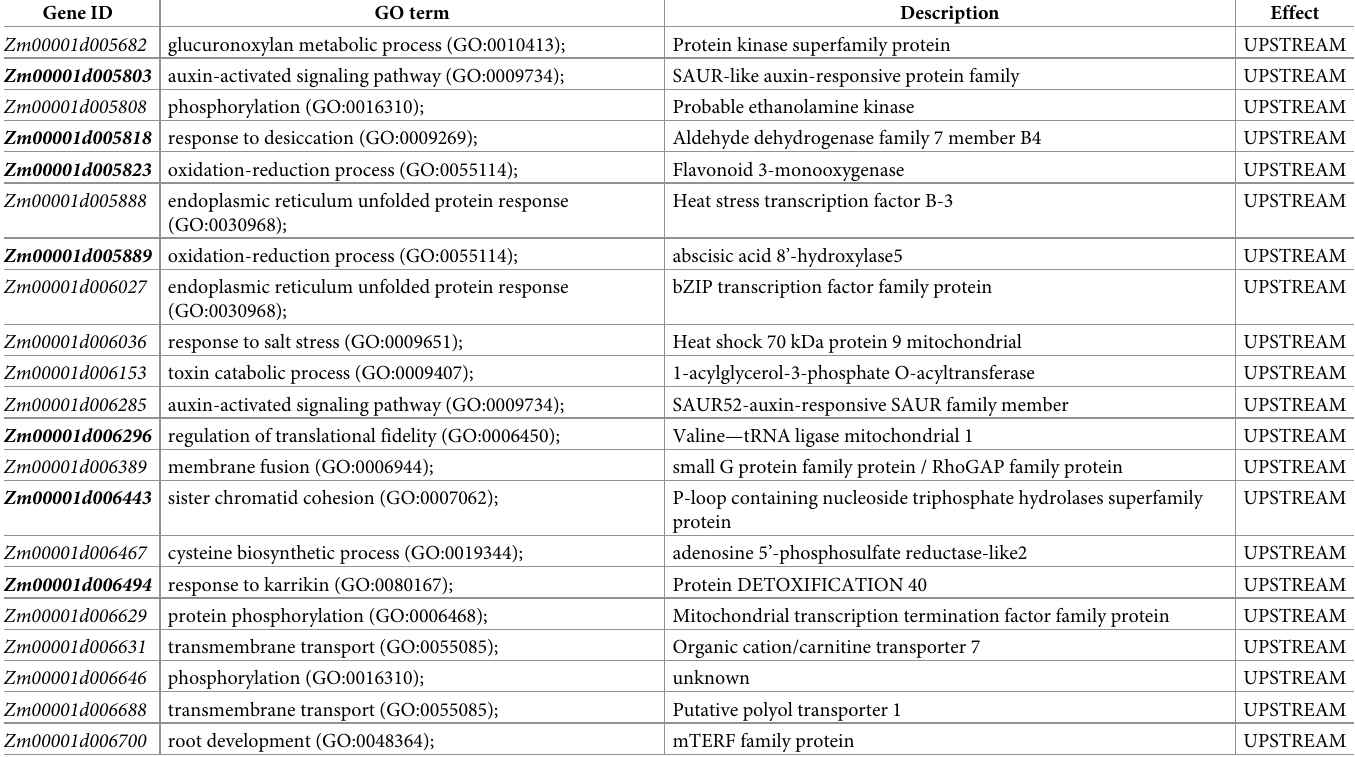
Table 4. Selected candidate genes of leaf angle in qLA02-01 with mutations in the promoter